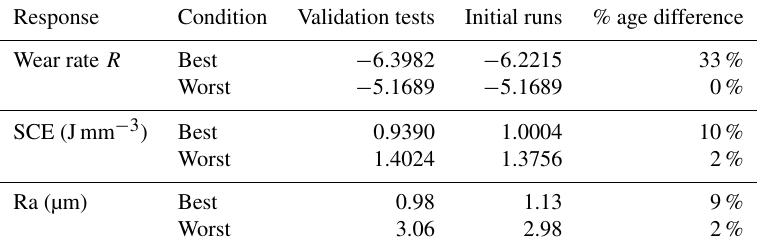
Table 10. Comparison of validation test results with initial